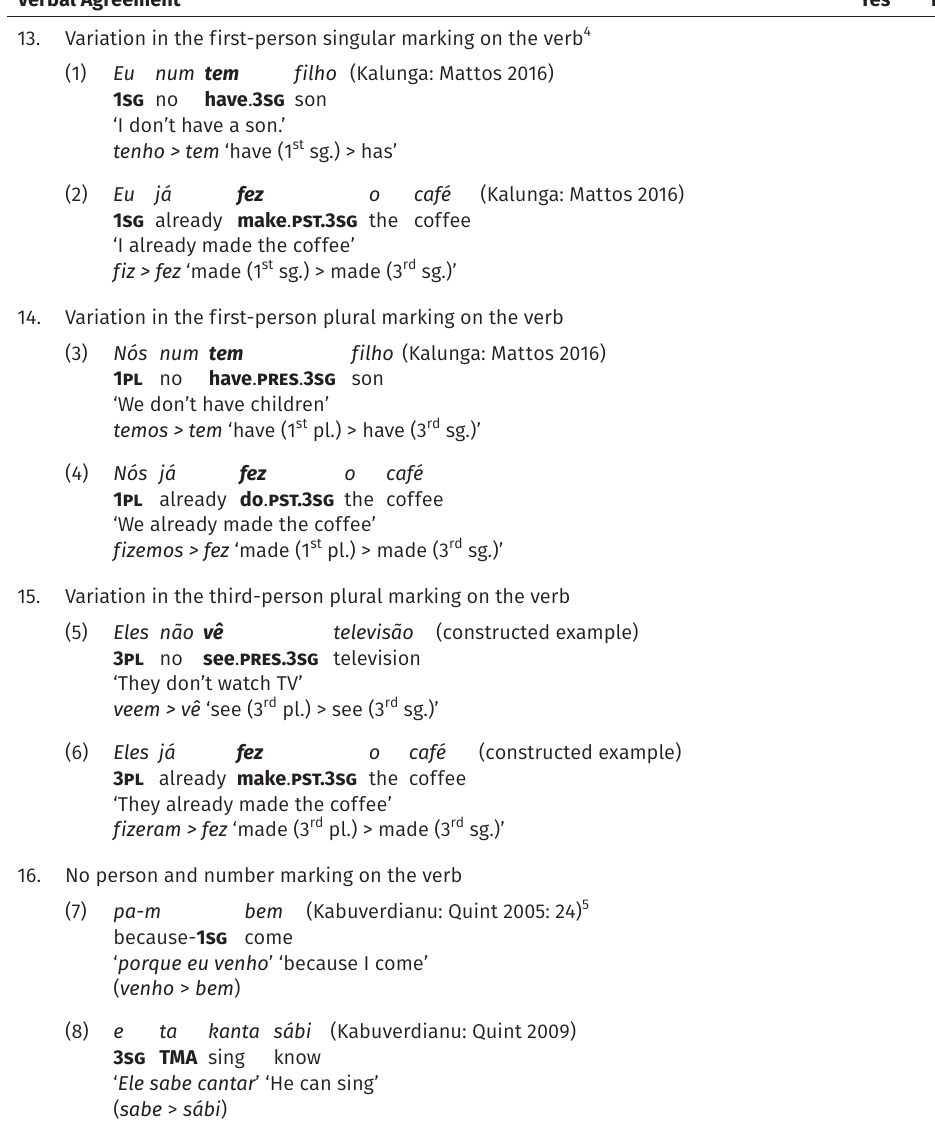
Table 3: Features related to VP agreement, extracted and translated from Dialectal Features Table. Verbal Agreement Yes